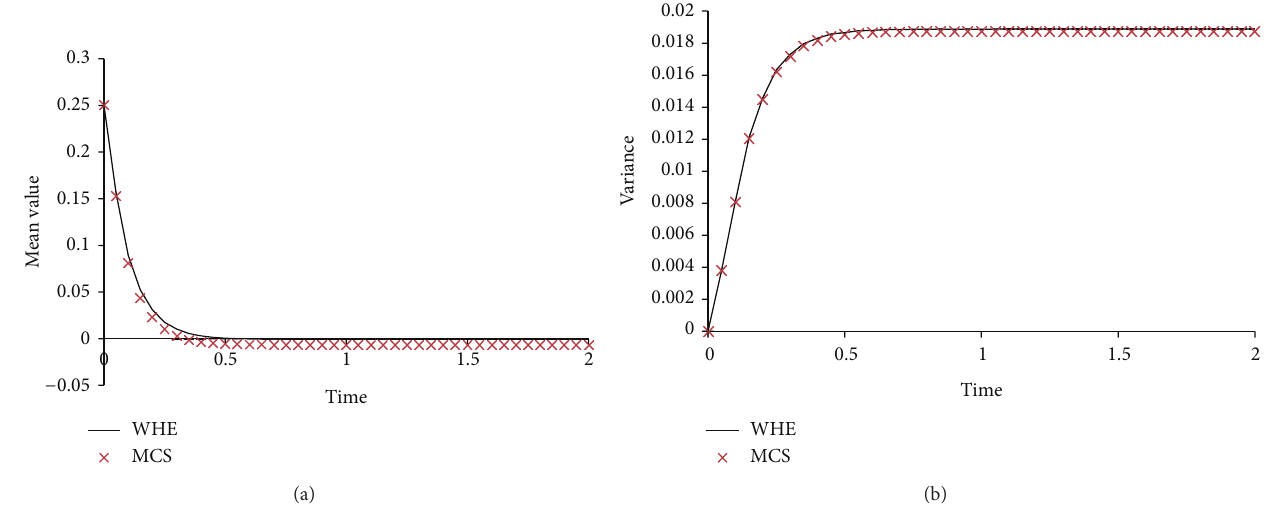
Figure 3: Variation of the mean solution (a) and the variance (b) with the time using WHE and 10 6 MCS simulations at x = 0.5 and 𝜆 = 0.5.